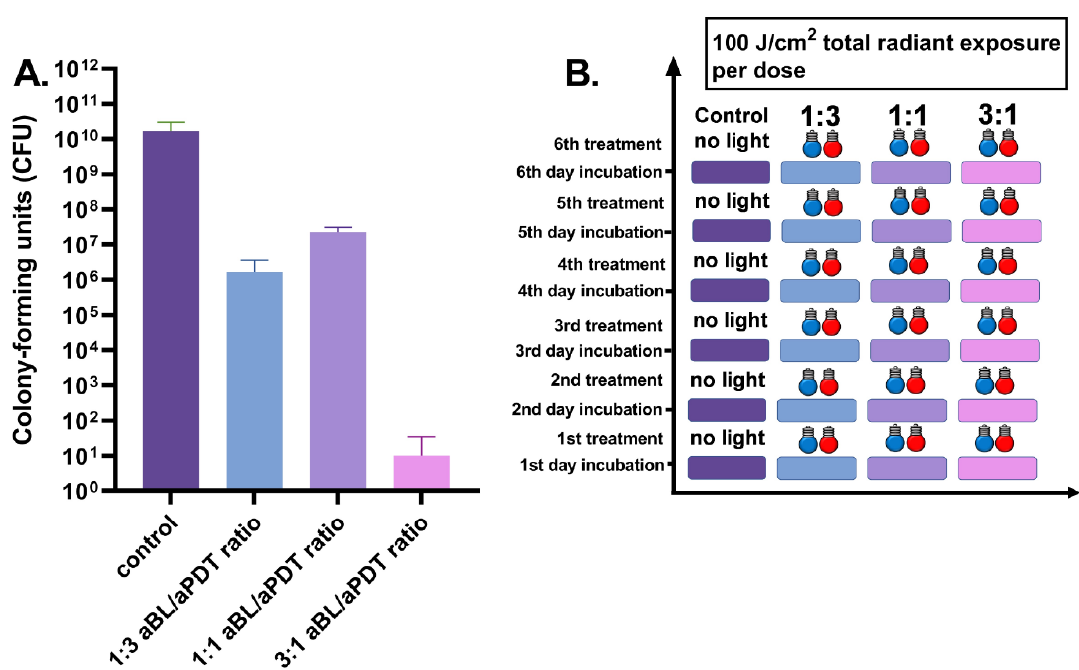
Figure 4. ( A ). Effects of different irradiance ratios of aBL and aPDT in the dual-light aPDT system in six-day S. aureus biofilm, when the antibacterial treatment is given once daily. Six-day S. aureus biofilm, daily-dose dual-light aPDT: 1:3 aBL/aPDT ratio vs. 1:1 aBL/aPDT ratio, p = 0.0022; 1:3 aBL/aPDT ratio vs. 3:1 aBL/aPDT ratio, p = 0.0022; 1:1 aBL/aPDT ratio vs. 3:1 aBL/aPDT ratio; p = 0.0022. The y -axis displays the median of CFUs. Six assays were performed for each experiment, and the control biofilm was performed in three assays. The 95% confidence interval (CI) is presented by using t-bars. ( B ). A schematic representation of the